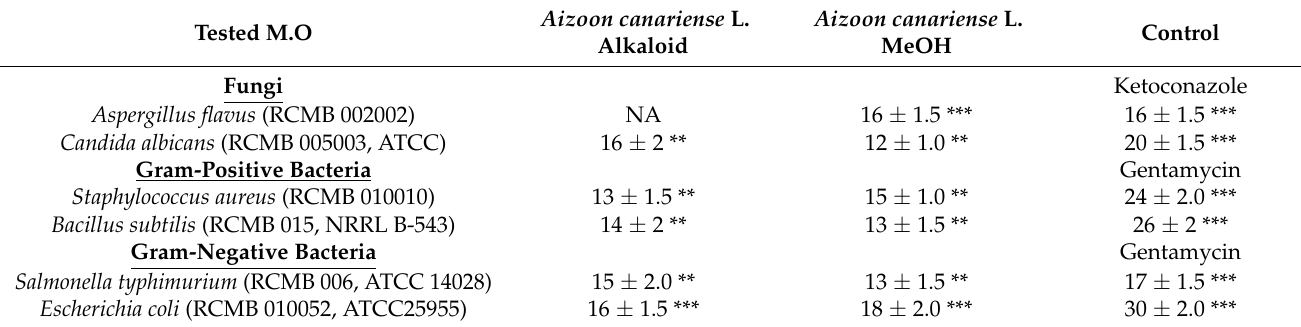
Table 4. Mean inhibition zones in mm of alkaloidal and methanolic Aizoon canariense L. extracts. Tested M.O